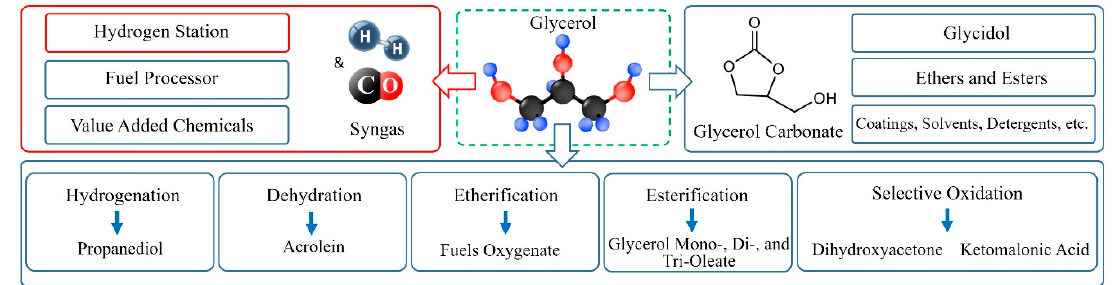
Figure 2. Various products synthesized from glycerol [20] (redrawn with copyright permission).